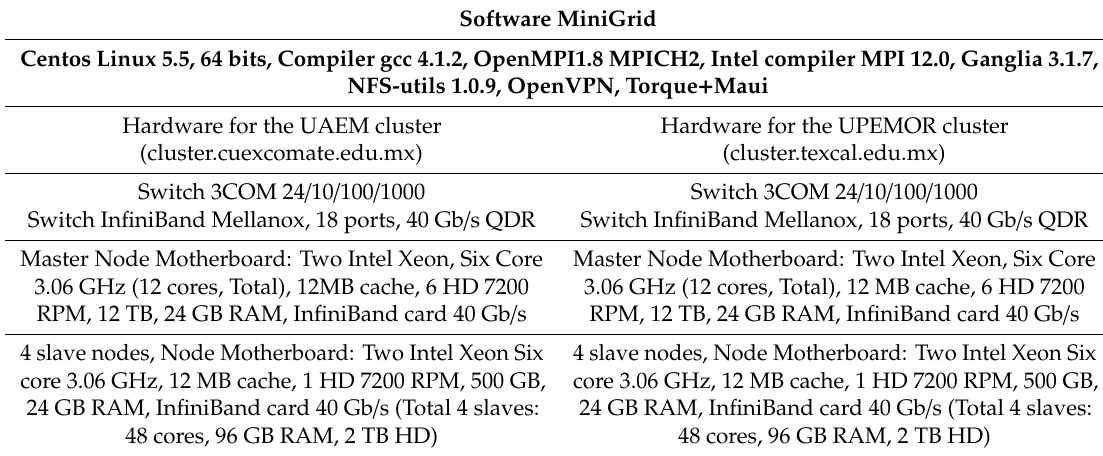
Table 3. Infrastructure of hardware and software for the MiniGrid. Software